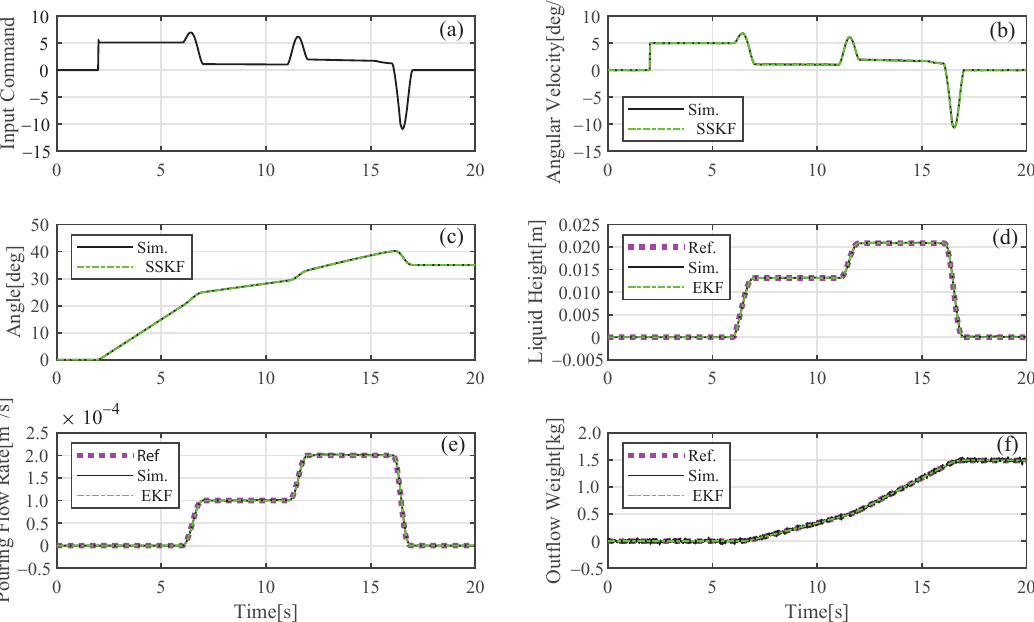
Figure 11. Simulation results of flow-rate estimation with error of tilting angle +0 deg at the start of liquid outflow. ( a ) Input command to motor for tilting ladle; ( b ) Angular velocity of tilting ladle; ( c ) Angle of tilting ladle; ( d ) Liquid height on pouirng mouth; ( e ) Flow rate of outflow liquid from ladle; ( f ) Weight of outflow liquid from ladle. The black solid lines are the results simulated using the motor model, and the chained lines are the results estimated using the SSKF. Furthermore, (d–f) indicate the liquid height, the pouring flow rate, and the outflow weight, respectively. The dotted magenta lines are the reference values, and the black solid lines are the results simulated using the pouring process model. The chained green lines are the results estimated using the